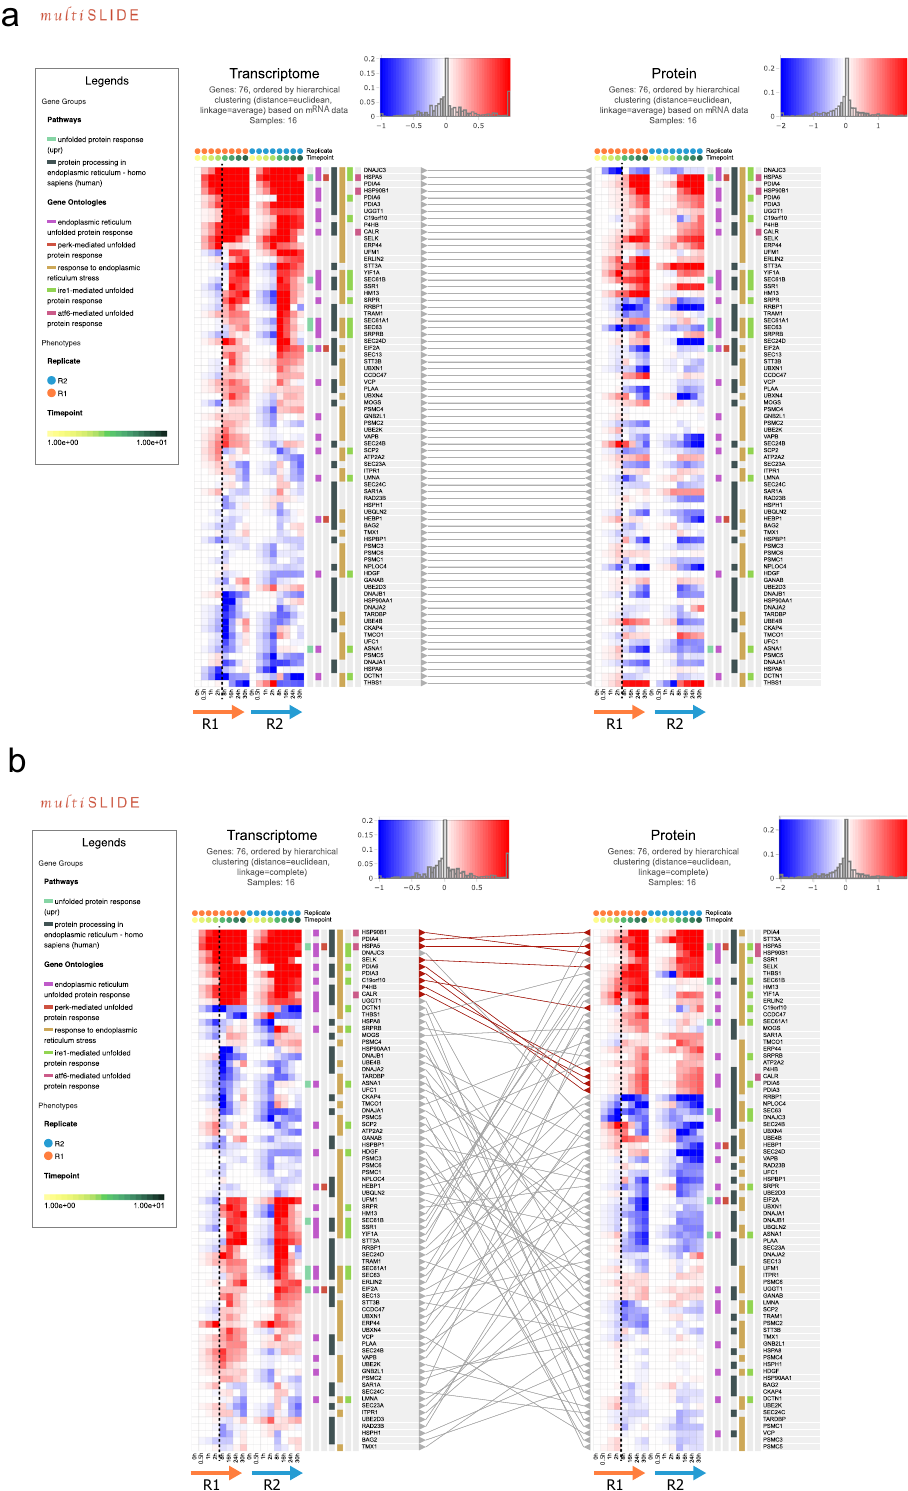
Fig. 2 Visualization of unfolded protein response in mammalian cells responding to stress. mRNA and protein-level expressions, across eight time- points (0, 0.5. 1, 2, 8, 16, 24, and 30 h after treatment) and two replicates, are jointly visualized in multiSLIDE to understand the dynamics of UPR under ER stress. The Legends panel, on the left, enumerates the selected GO terms and pathways. The colored tags in vertical tracks alongside the heatmap indicate associations between genes and GO terms/pathways. Panels a and b represent the two modes of visualization, synchronized and independent (unsynchronized), respectively. In the synchronized clustering mode, the same order of genes is applied to both the mRNA and protein levels. In the independent clustering mode, mRNA and protein data were clustered independently, using Euclidean distance and complete